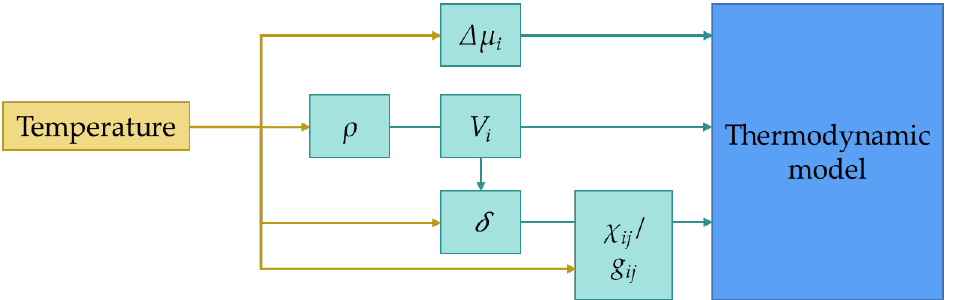
Figure 2. Influence of the temperature on different parameters that are part of the thermodynamic model.